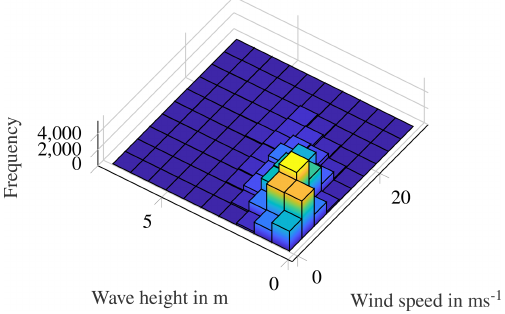
Figure 9. Correlation of wind speeds and wave heights. Histogram based on mean values of all 10min intervals in